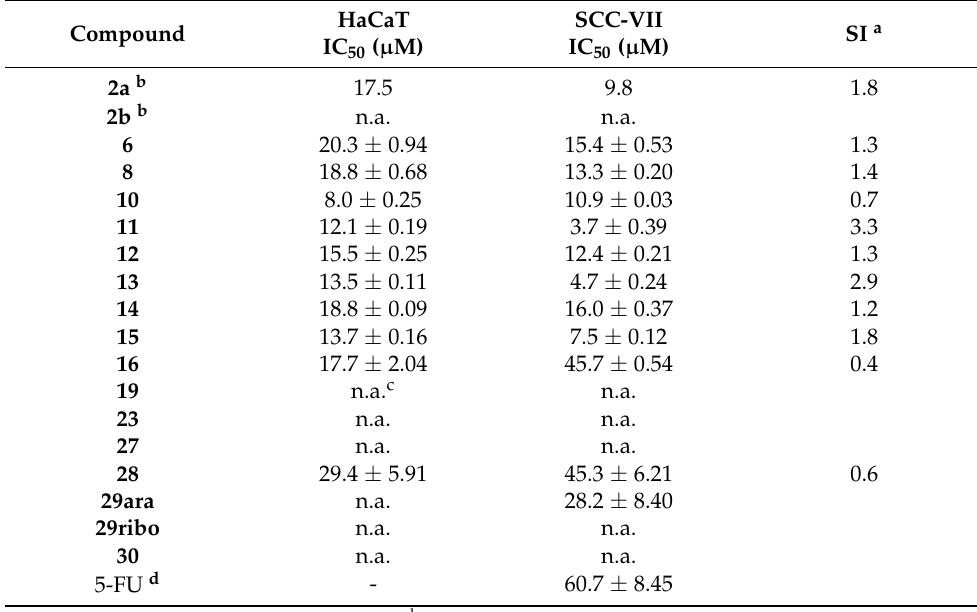
Table 2. Cytotoxic activity of the compounds on healthy (HaCaT) and tumorous (SCC) cell lines.